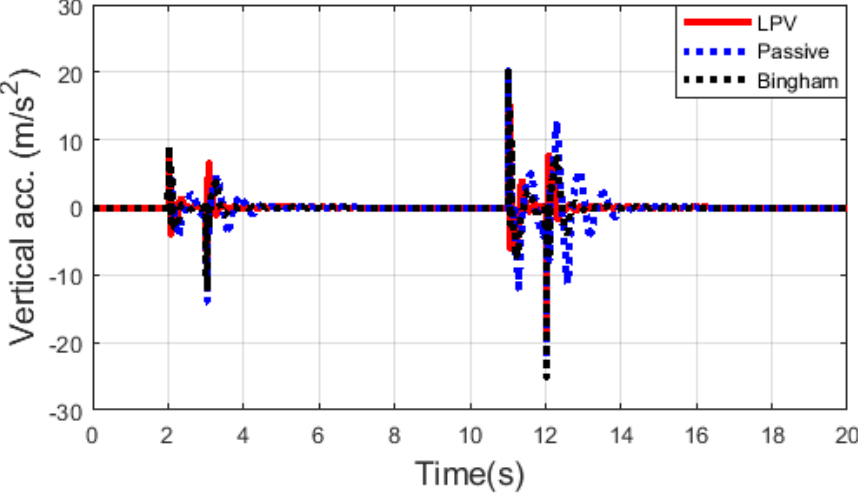
Figure 4. Vertical